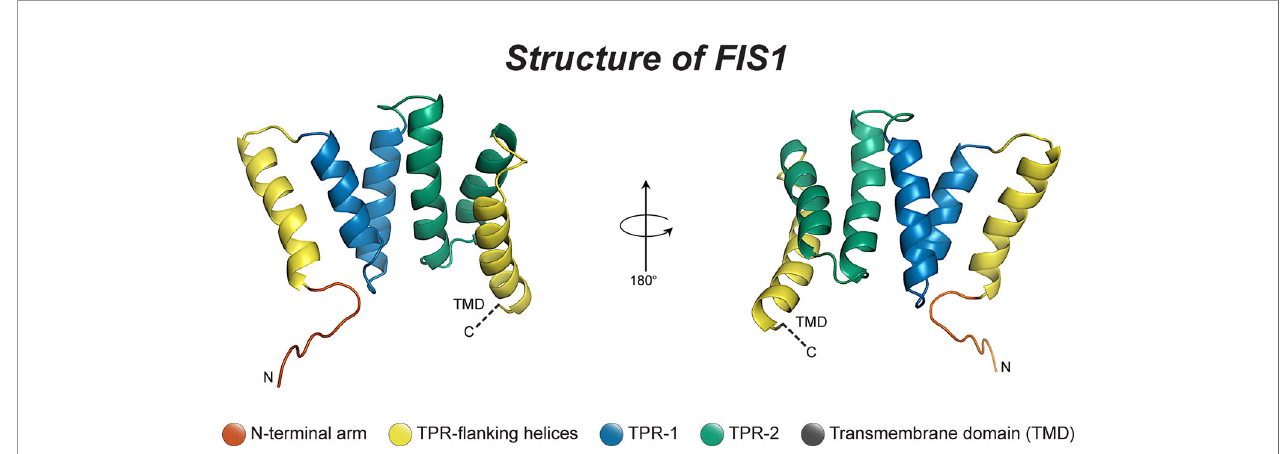
FIGURE 1 | The structure of human Fis1. The structure of human Fis1 (NMR structure PDB: 1PC2). Fis1 is anchored to the mitochondrial outer membrane by a C- terminal transmembrane domain exposing a soluble domain to the cytoplasm that is comprised of two core tetratricopeptide repeat (TPR) structural motifs fl anked by two helices (helices 1 and 6). The N-terminal region of Fis1 is referred to as the “ N-terminal arm ” . The transmembrane domain (TMD) has been truncated here and its structure in the membrane is unknown but presumably helical.